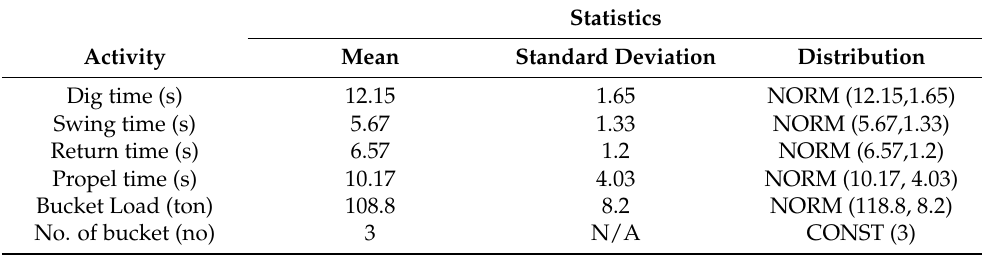
Table 6. Hypothetical improved autonomous shovel key activity statistics.